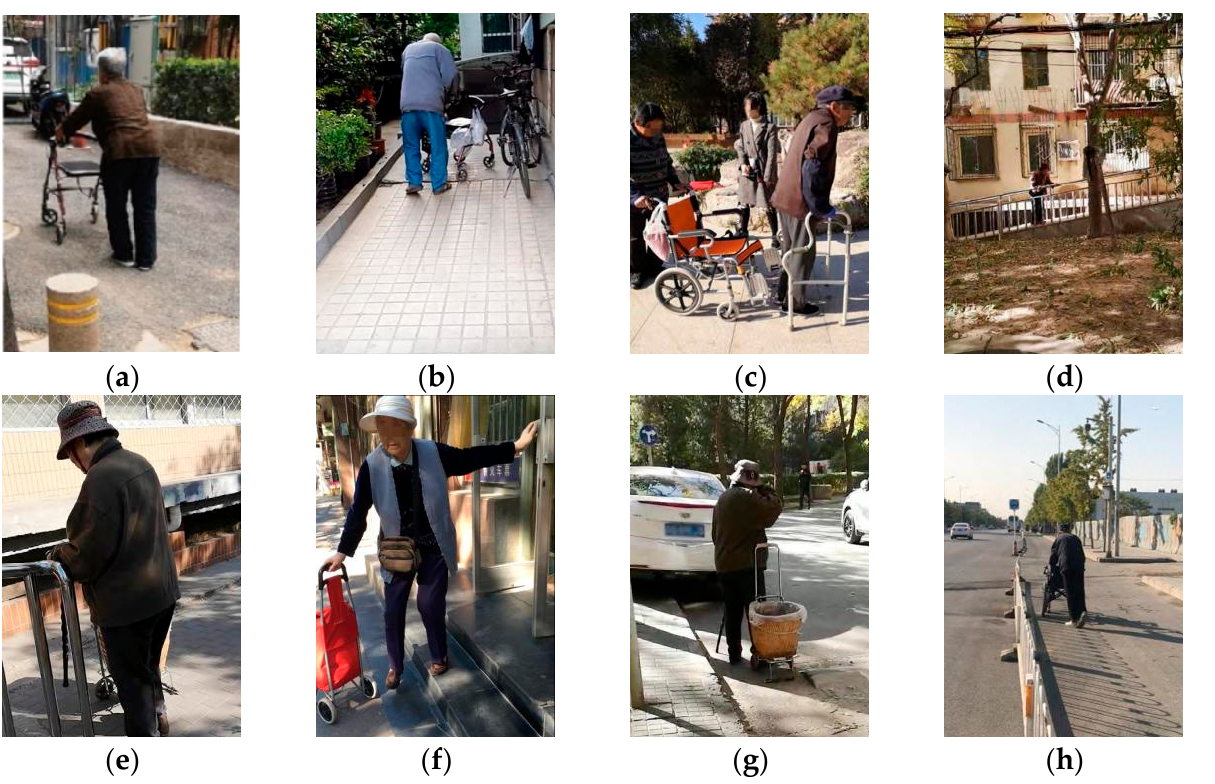
Figure 1. Physical activities of elderly individuals using walking aids. Including: ( a ) on level ground, ( b ) on uneven ground, ( c ) getting up after sitting down for a long time, ( d ) going uphill and downhill, ( e ) climbing the stairs, ( f ) carrying heavy objects, ( g ) obstacles, and ( h ) walking for a long time.